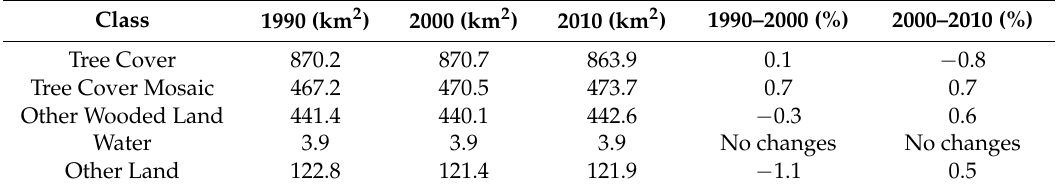
Table 3. LULC and evolution of land cover in the UMNP. km 2 and %